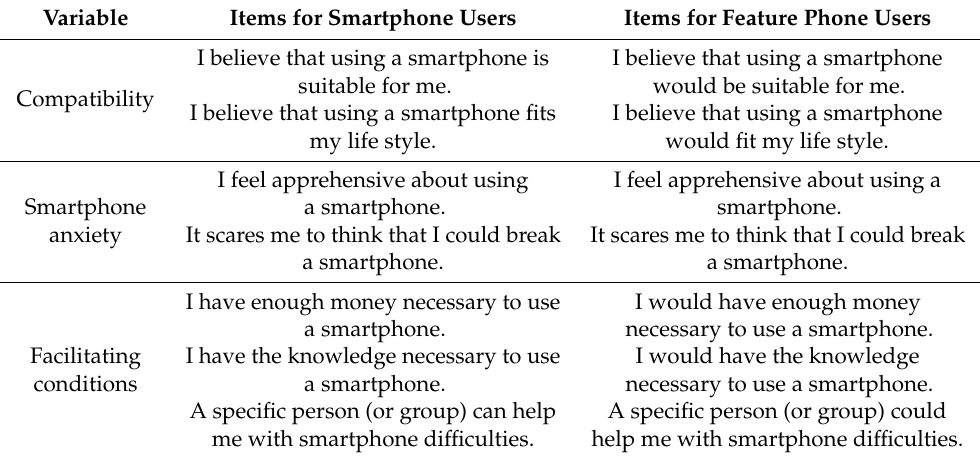
Table A2. Questionnaire items for compatibility, smartphone anxiety and facilitating